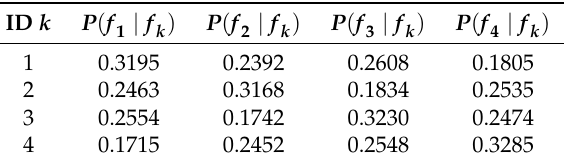
Figure 10. Example of shape matrices indentification (ID.2). Table 2. Measurement model 1 (range of view : 1.25 m).